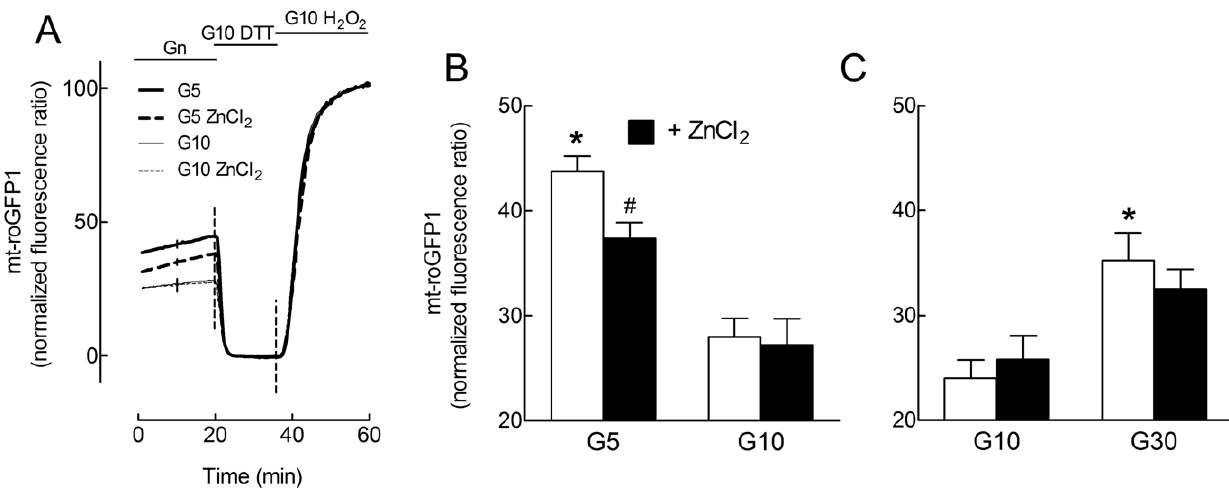
Figure 5. Effects of glucose and ZnCl 2 on mitochondrial thiol/disulfide equilibrium in cultured rat islet cell clusters. Rat islet cell clusters infected with an adenovirus coding mt-roGFP1 were cultured overnight in the presence of G5, G10 or G30 6 50 m mol/l ZnCl 2 as indicated. The ratio of mt-roGFP1 fluorescence intensities (exc 405/480 nm) was measured during 20 min of perfusion in a medium containing the same glucose concentration and expressed as a percentage of the difference between the mean ratio measured from 4 to 8 min after addition of 10 mmol/l DTT (set at 0%) and that measured from 14 to 18 min after addition of 1 mmol/l H 2 O 2 (set at 100%) (B,C). Results are means 6 SEM for 3 experiments (9– 19 clusters). B,C, *, P , 0.05 for the effect of G5 or G30 vs. G10 and # , P , 0.05 for the effect of ZnCl 2 by two-way ANOVA followed by a test of Bonferroni. thiol (e.g. glutathione) oxidation in the mitochondrial matrix. Addition of ZnCl 2 to the culture medium diminished by , 40% the level of mt-roGFP1 oxidation in G5, and tended to reduce by , 23% that in G30. These results suggest that ZnCl 2 exerts some antioxidant effect in rat islet cell clusters exposed to low and high vs. intermediate glucose concentrations.